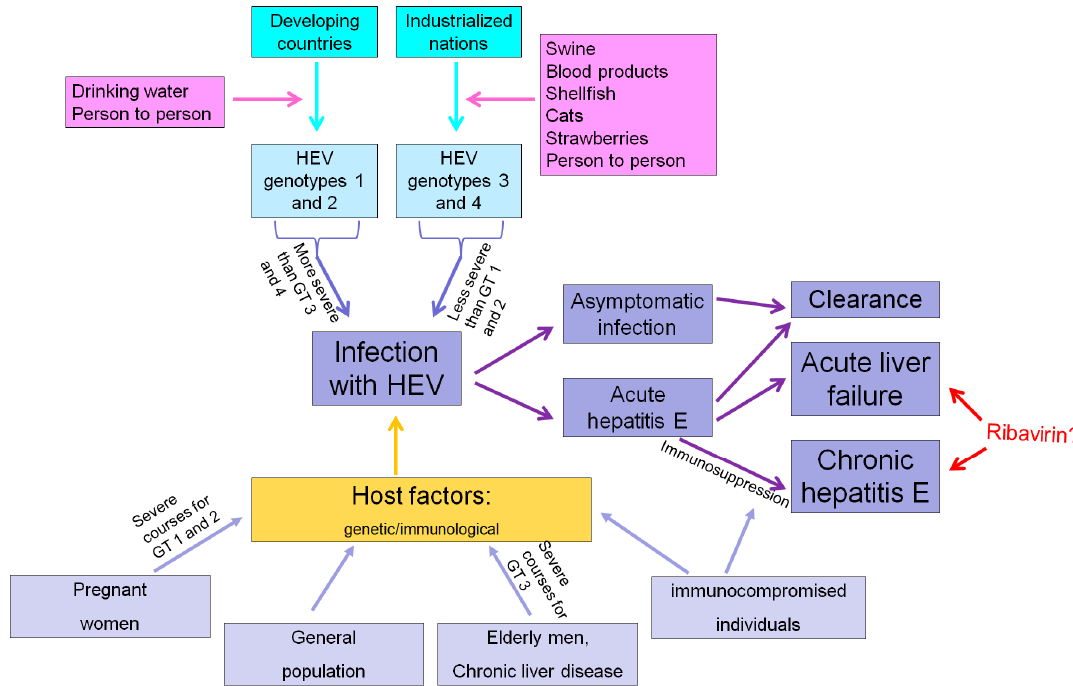
Figure 1. Possible courses of hepatitis E virus (HEV) infection. GT, genotype.